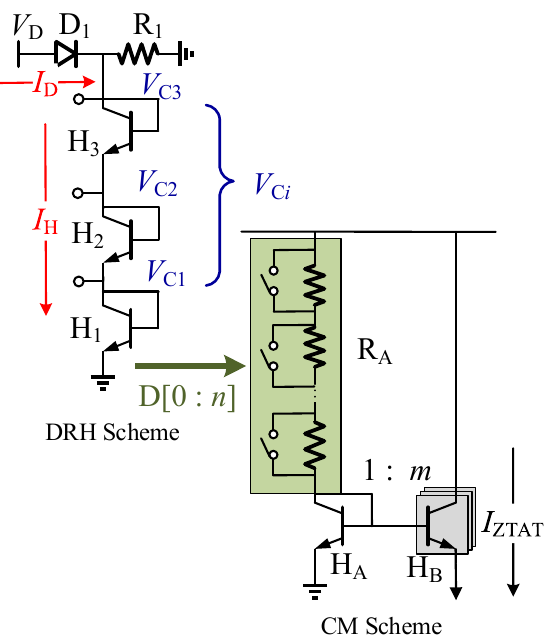
Figure 2. Simplified scheme of the proposed adjustable ZTAT bias circuit. The DRH scheme, which consists of a diode D 1 , a resistor R 1 and a branch of HBTs, generates a set of temperature-sensing voltages V C i with different TCs. Assuming the currents of the diode and HBTs are I D and I H , respectively, the collector voltage V C3 of the top HBT is given